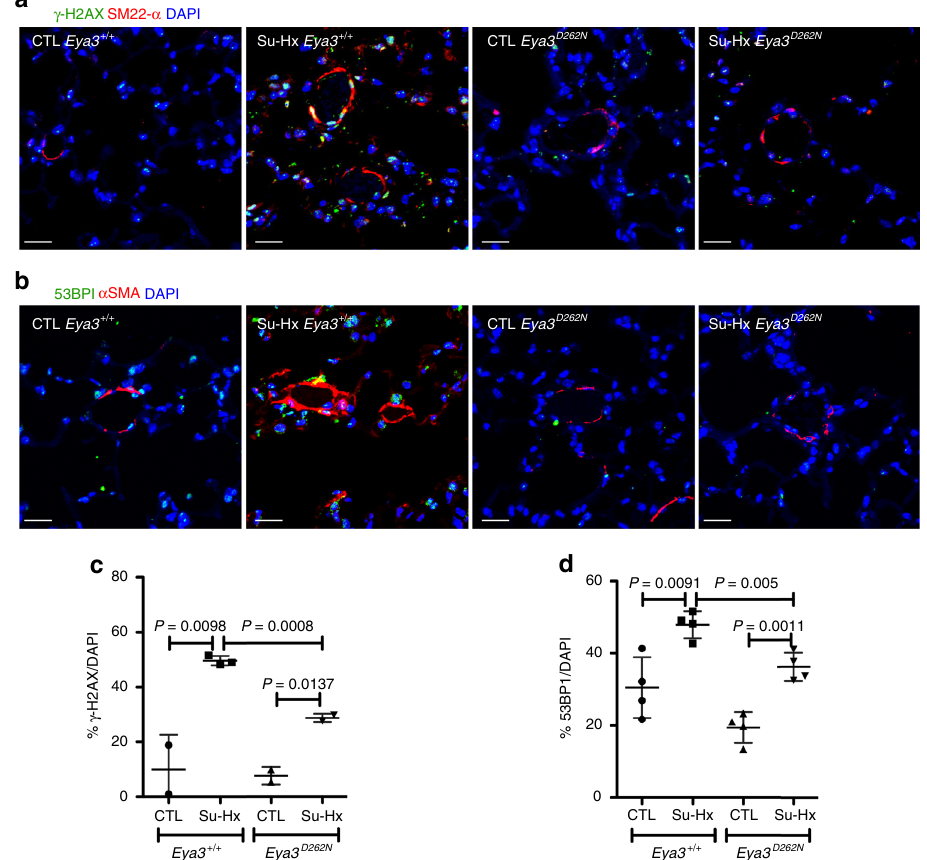
Fig. 8 Genetic loss of EYA3 PTP activity reduces markers of DNA damage and repair. a Genetic loss of EYA3-PTP activity reduces the formation of γ -H2AX foci in lungs of mice subject to the Su-Hx protocol. γ -H2AX (green) and smooth muscle cells (red; SM22- α staining) as seen in lung sections of Eya3 + / + and Eya3 D262N mice either maintained in room air (CTL) or subject to the Su-Hx protocol. DAPI (blue) staining indicates nuclei; scale bar = 20 μ m. b Genetic loss of EYA3-PTP activity reduces the formation of 53BP1 foci in lungs of mice subject to the Su-Hx protocol. 53BP1 (green) and smooth muscle cells (red; α -SMA staining) as seen in lung sections of Eya3 + / + and Eya3 D262N mice either maintained in room air (CTL) or subject to the Su-Hx protocol. DAPI (blue) staining indicates nuclei; scale bar = 20 μ m. c Quantitation of γ -H2AX-positive cells. Tissue sections were analyzed for DNA-damage repair as marked by the presence of γ -H2AX foci. At least four sections per animal were averaged for each data point. Eya3 + / + mice maintained in room air n = 2, Eya3 + / + mice subject to the Su-Hx protocol n = 3, Eya D262N mice maintained in room air n = 2, Eya3 D262N mice subject to the Su-Hx protocol n = 2. Data plotted as the mean ± SD, statistical signi fi cance derived from pairwise t -tests. d Quantitation of 53BP1-positive cells. At least four sections per animal were averaged for each data point. Data plotted as the mean ± SD ( n = 4 in each group), statistical signi fi cance derived from pairwise t -tests. Source Data are provided as a Source Data fi